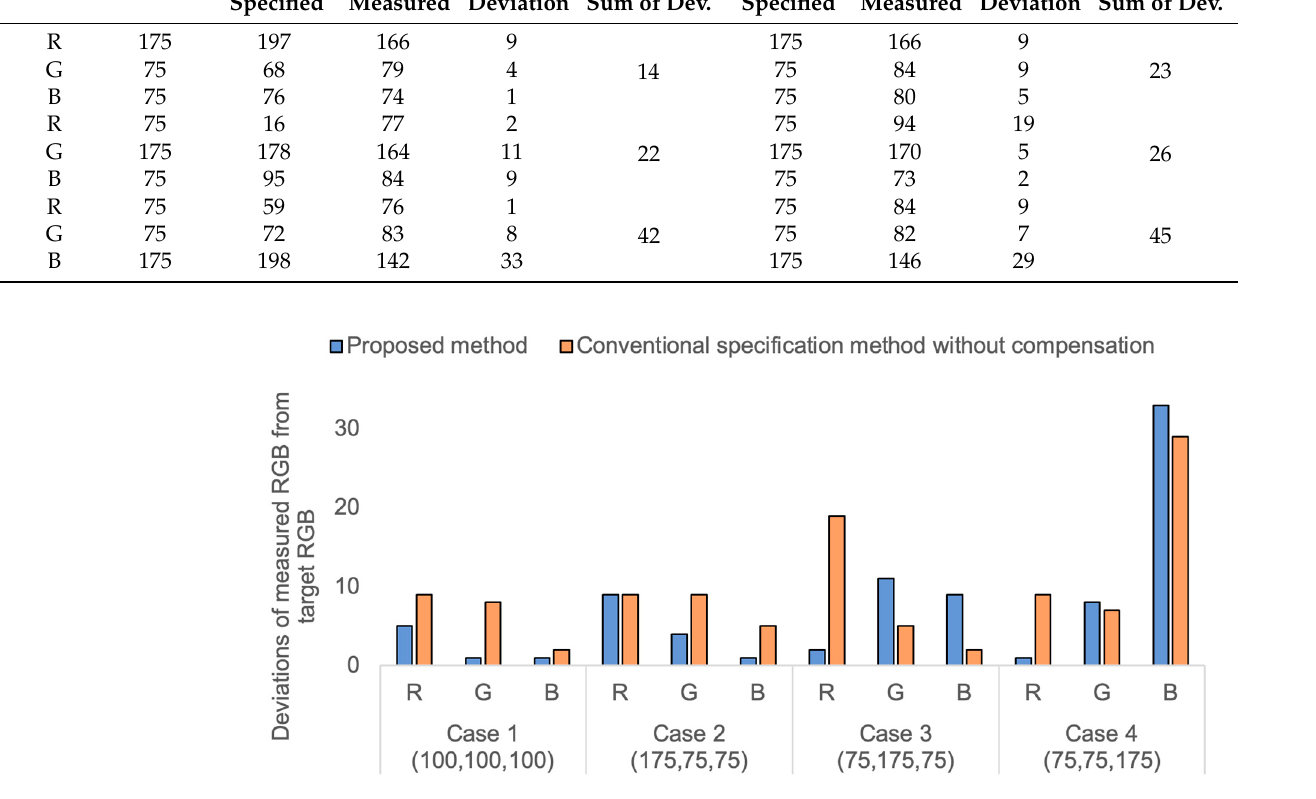
Table 4. Comparison of deviations of measured RGB values on printed samples from the target RGB values using the proposed method versus the conventional specification method without compensation.